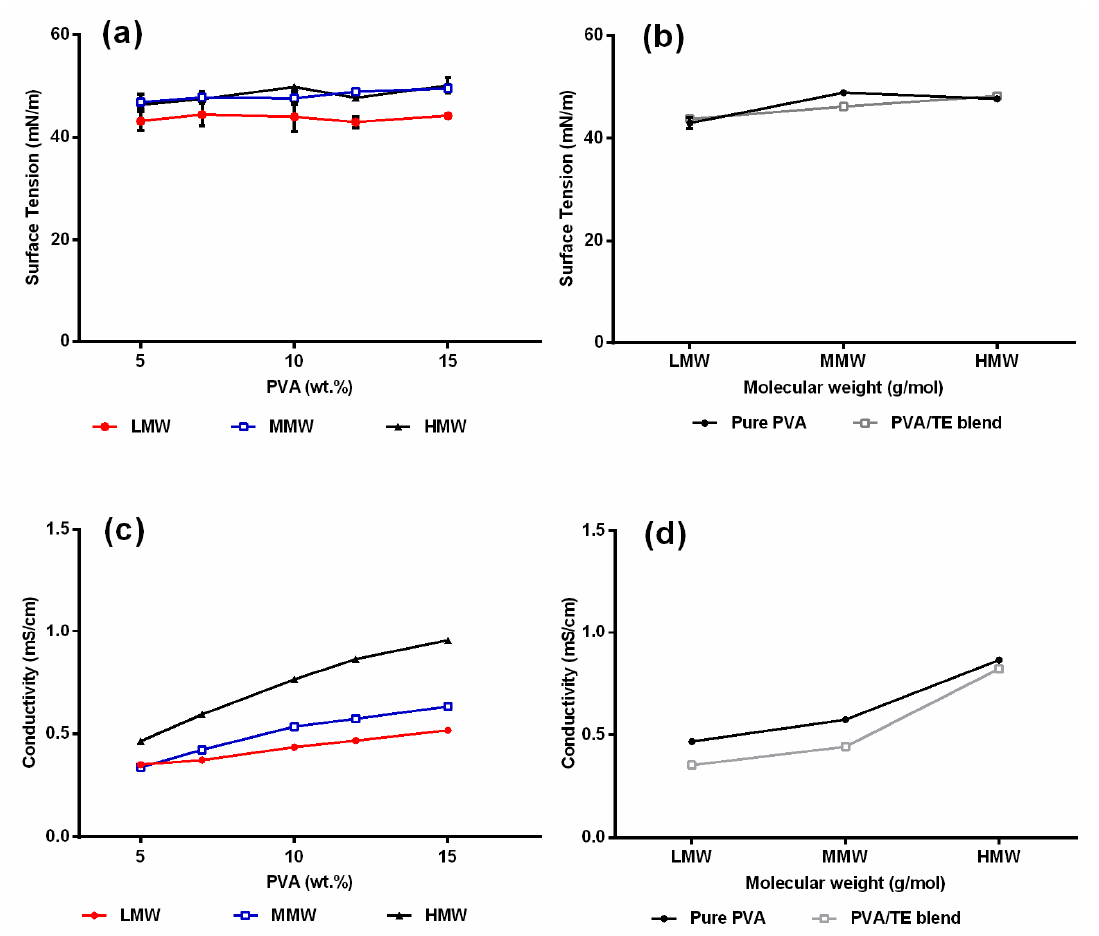
Figure 4. ( a ) Surface tension and ( c ) conductivity as a function of PVA concentration and molecular weight. ( b ) Surface tension and ( d ) conductivity of blended PVA / TE solution (60:40) at di ff erent molecular weights (error bars are smaller than the symbol size).